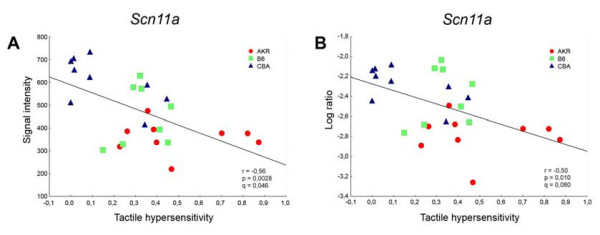
Regulation of expression of the TTX-R Na+ channel alpha subunit Scn11a after L5 SNL correlated negatively with the degree of tactile hypersensitivity. Each symbol represents one mouse of the AKR, CBA or B6 strain. Expression data, for individual mice, are plotted as: A, the raw signal intensity values associated with Scn11a gene expression, and B, the log ratio of the signal intensity of the individual mouse divided by the average signal intensity of all sham operated mice of the same strain. The value for tactile hypersensitivity for these mice was normalized as indicated in the Methods, where increasing values indicate greater sensitivity. r = Pearson correlation coefficient, p = statistical significance of r, q = false discovery rate (FDR) coefficient associated with Scn11a in the microarray analysis.